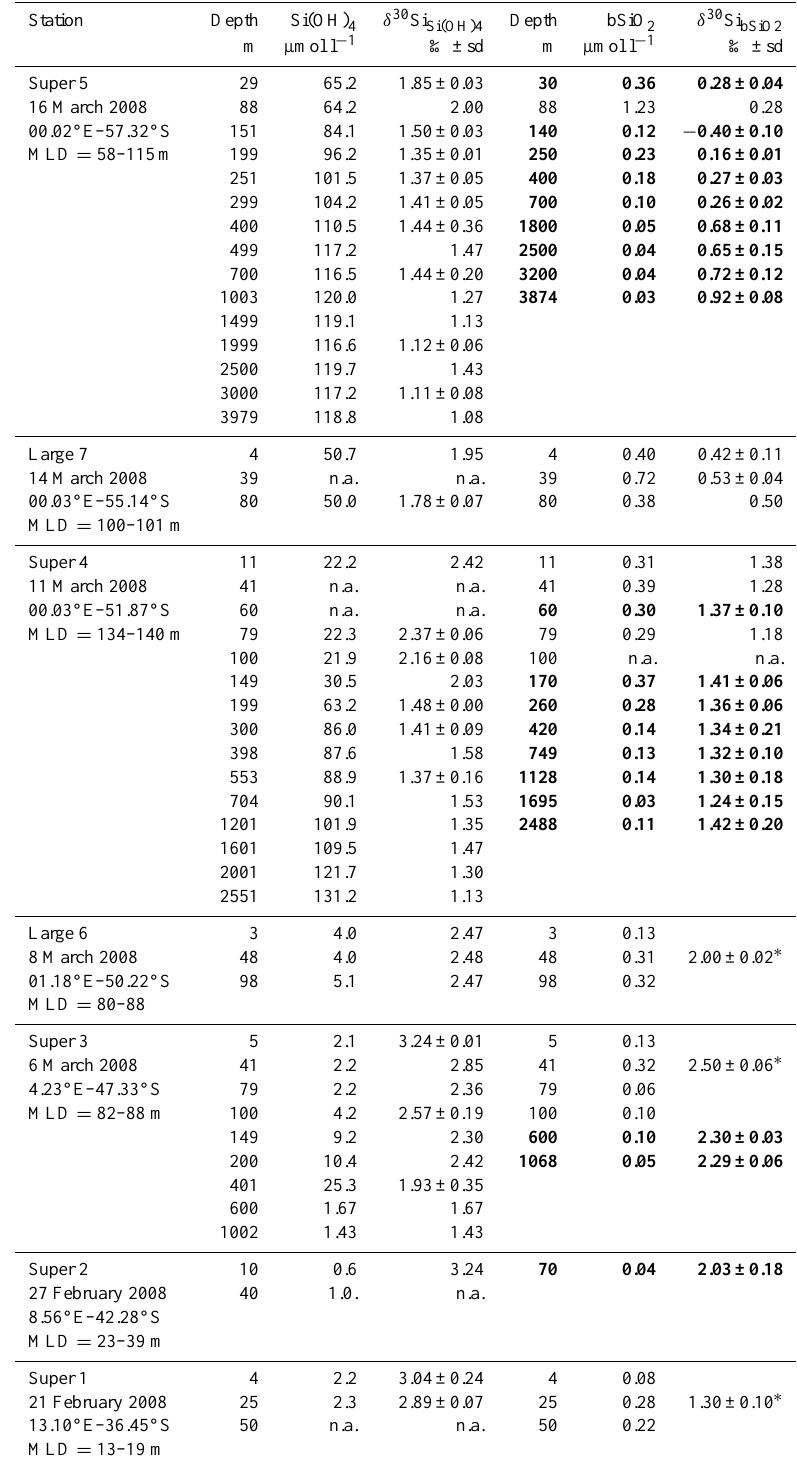
Table 1. Si(OH) 4 and bSiO 2 concentrations and isotopic compositions. Only the standard deviations for duplicates are shown. Bold num- bers represents samples from in situ pumps. The mixed layer depth (MLD) has been determined using a combination of threshold den- sity/temperature criterions relative to 10m ( 1T °C = 0.2°C; 1σ = 0 . 03 and 0.125 kg m − 3 ; De Boyer Mont´egut et al., 2004). δ 30 Si-Si(OH) 4 data are from Fripiat et al.